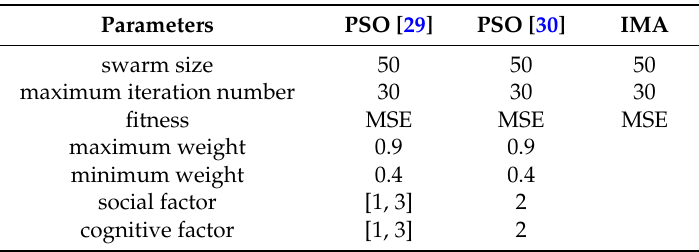
Table 2. Parameters setting of